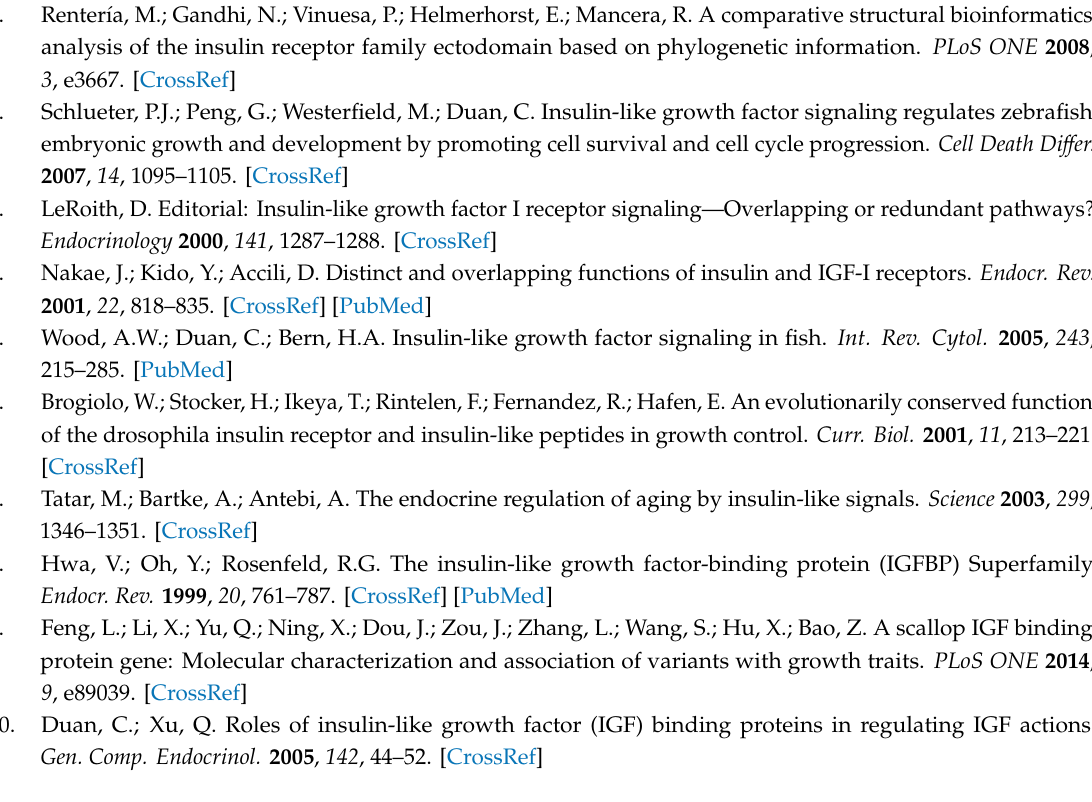
Figure S1: Hdh IGFBP-5 mRNA expression in the neural ganglion (cerebral, pleuropedal, and branchial), adductor muscle, mantle, and gonad (testis and ovary) was determined by semi-quantitative RT-PCR. For normalization of mRNA expression in tissues, RPL-5 gene was used as an internal